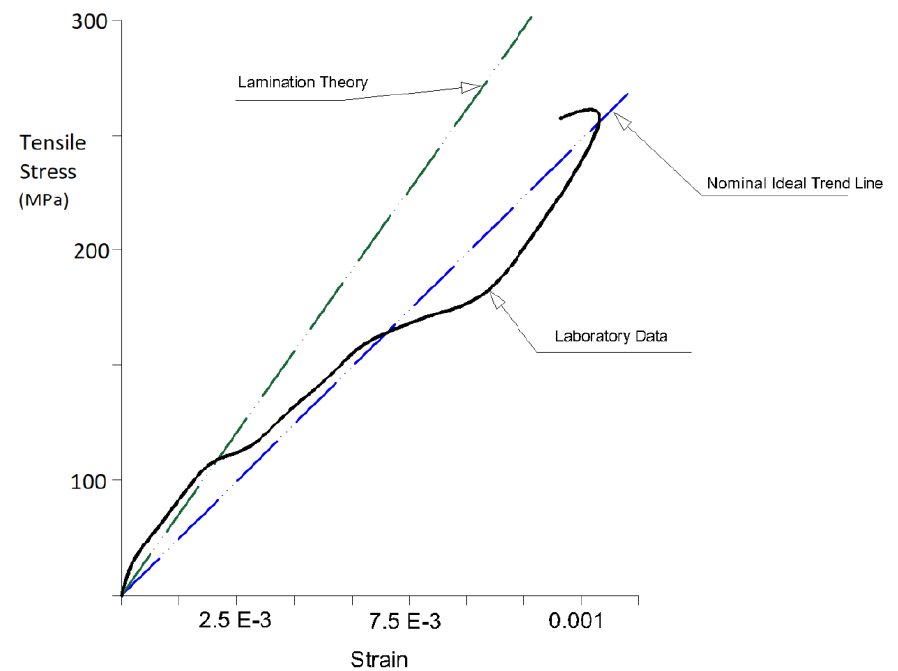
Figure 3. Axial compression load-deflection response of the test beam specimens.